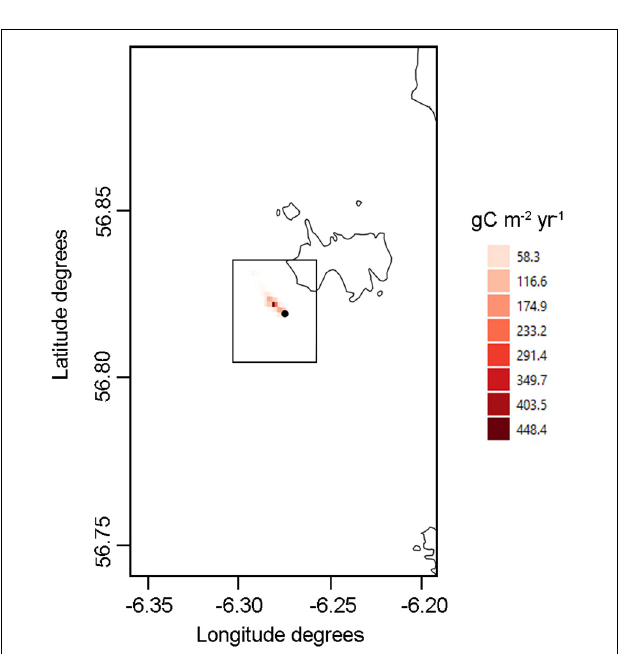
FIGURE 4 | NewDEPOMOD annual carbon deposition output interpolated by the georeferenced Ecospace model domain (100 m × 100 m).